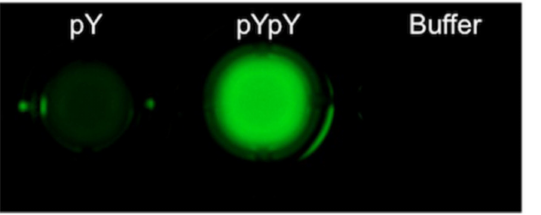
Figure 6. Fluorescence image of peptides (25 µ M) by treatment with probe 2 (50 µ M) under Bio-Rad ChemiDoc MP imaging system [35].